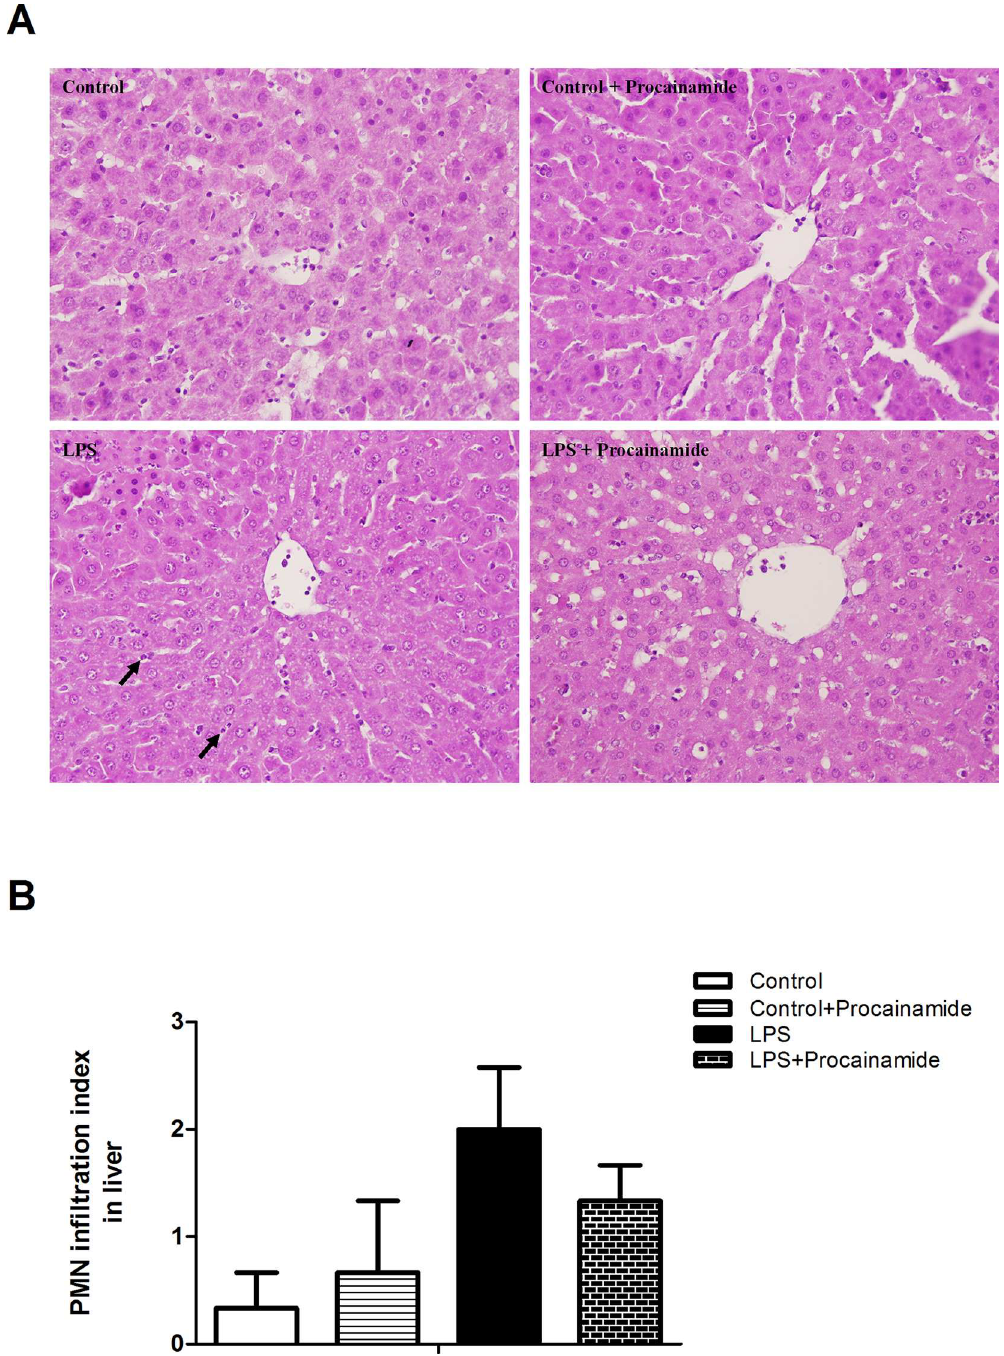
Fig 6. (A) Representative histopathologic featuresand (B) polymorphonuclear neutrophil (PMN) infiltration index of liver tissue sections obtained from endotoxemic rats. Depictedare changesin PMN infiltrationindexat the end of experiment(at 6 h) in differentgroupsof animalsthat receivedsalineat time 0 (Control, n = 3), received saline as in Control groupand then receivedprocainamide at 1 h (Control + Procainamide, n = 3), receivedLPS at time 0 (LPS, n = 3), andreceivedLPS at time 0 and then receivedprocainamide at 1 h (LPS + Procainamide, n = 3). Data are expressedas mean ± SEM. * P < 0.05, all versus Controlrats; # P < 0.05, with versus without procainamide in LPS rats. Arrows representneutrophilinfiltration.Originalmagnification x